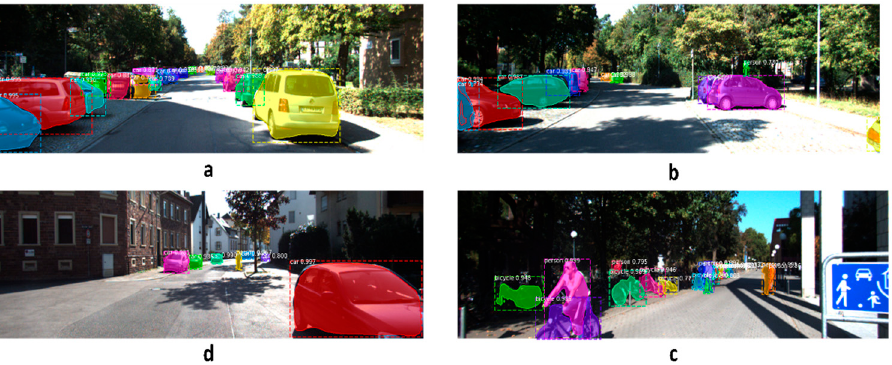
Figure 11. Performance of the trained instance segmentation model on a randomly selected frame from the KITTI dataset. Objects’ distance is color encoded; near objects have cold color while distant objects have warm colors.